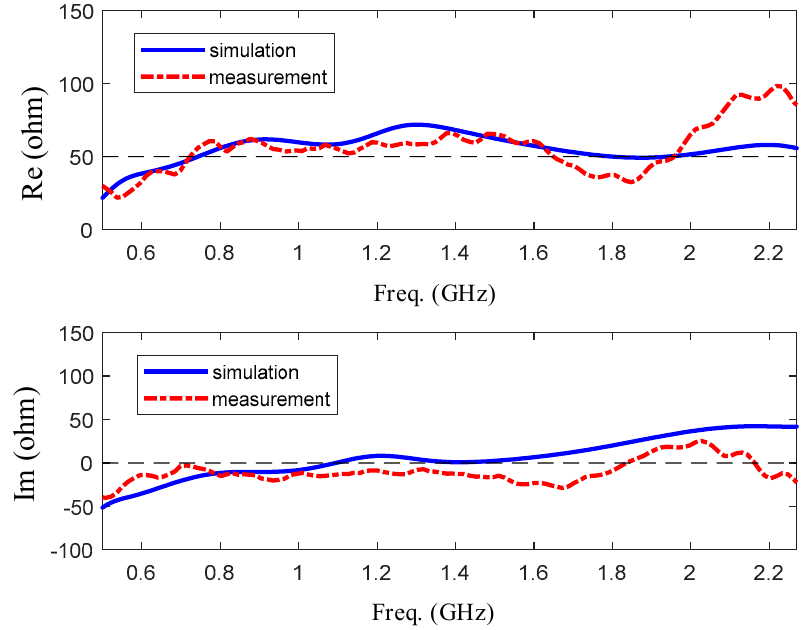
Figure 16. The comparison of reflection coefficient between measurement and simulation.